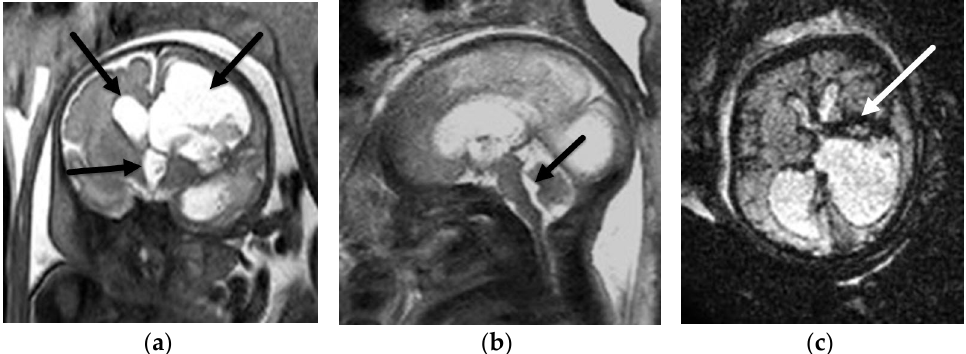
Figure 2. Aqueductal stenosis. Coronal ( a ) and sagittal ( b ) T2-SSFSE and axial EPI ( c ) images from a 34-week, 2-day GA fetus referred for ventriculomegaly on fetal ultrasound. There is severe ventriculomegaly of the lateral and third ventricles (( a ), black arrows) with a normal sized 4th ventricle (( b ), black arrow) consistent with aqueductal stenosis. The etiology, not identified on fetal US, is a left grade 4 germinal matrix hemorrhage best seen on the EPI blood sequence (( c ), white arrow) with hemosiderin staining along the ependymal margins of the ventricular system. Associated porencephaly of the left cerebral hemisphere is best seen on the coronal ( a ) image.